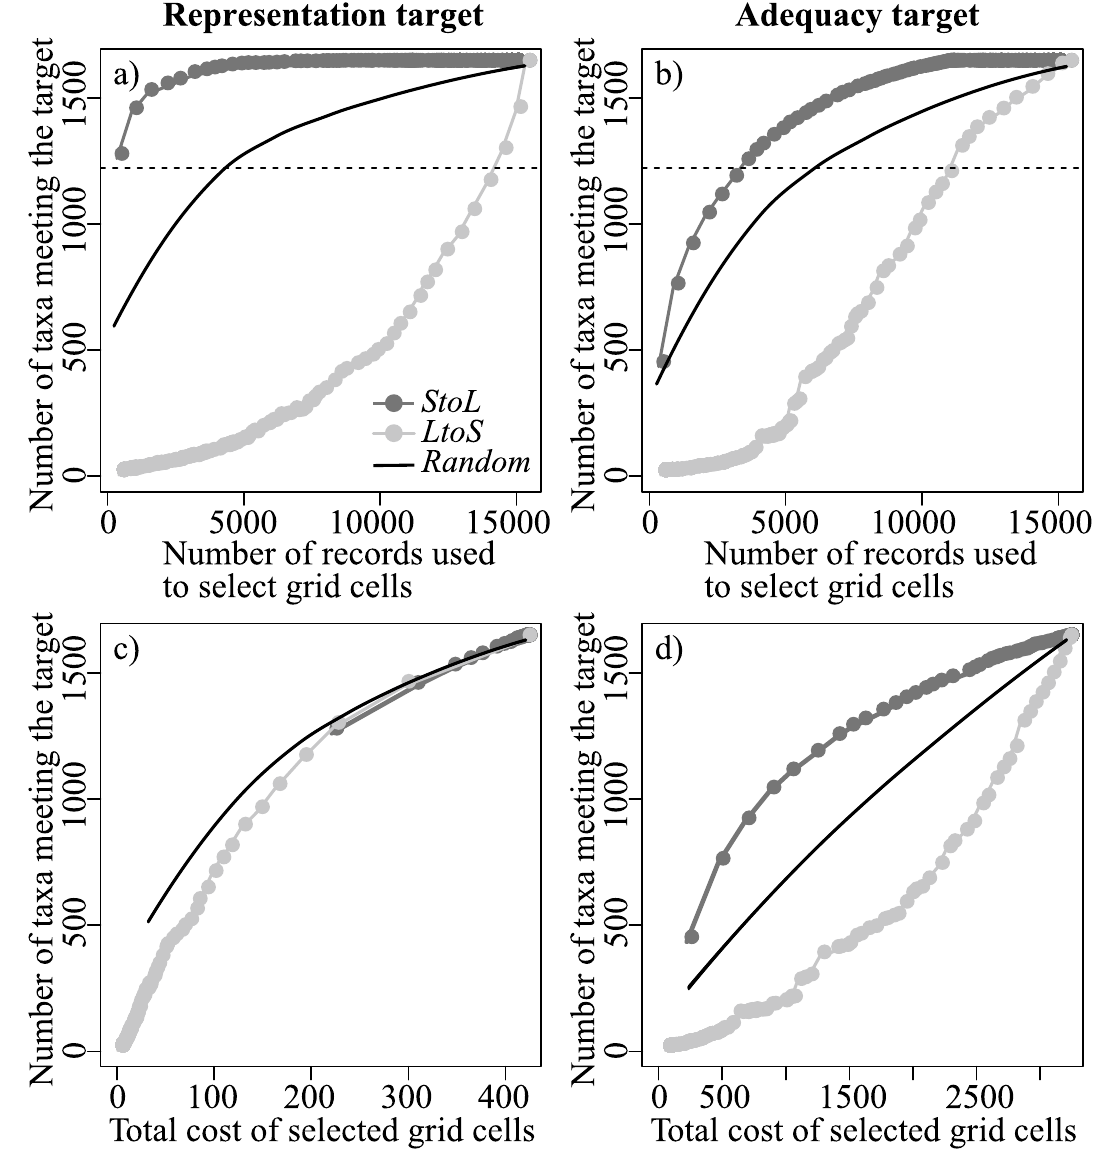
Figure 1. ( a , b ) Relationship between the number of records used to select grid cells ( x -axis) and the number of taxa meeting conservation targets ( y -axis) using taxa distribution data sequentially from small to large ( StoL : dark grey), large to small ( LtoS ; light grey) or a random order (black). For the random order, the relationship was displayed by drawing a lowess smoothing line of the 50 iterations together with 2SE error bounds (although error bounds are too narrow to visualize). ( c , d ) Relationship between total cost of selected grid cells ( x -axis) and the number of taxa meeting the target ( y -axis) for StoL (dark grey), LtoS (light grey) and random (black). Results for representation targets (i.e., representing one grid for each taxa) ( a , c ) and adequacy targets (i.e., representing 100% of the distribution for taxa with AOO ≤ 50 grid cells, and representing 50 grid cells for taxa with the larger AOO) ( b , d ). Horizontal dashed lines indicate 75% of the overall taxa used (1223